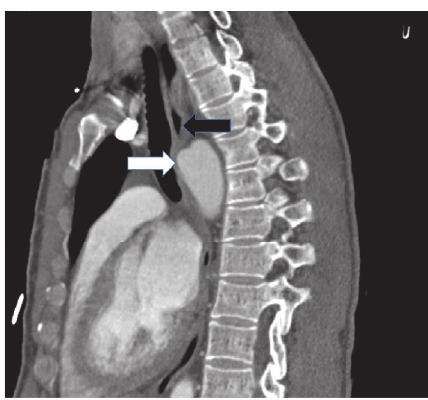
Figure 3: High resolution CT angiogram, sagittal view showing the ductus diverticulum (white arrow) indenting the esophagus (black arrow).